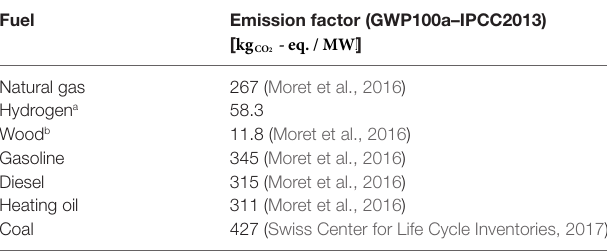
TaBle 3 | Impact associated with production, transport, and combustion of the fuels, LHV